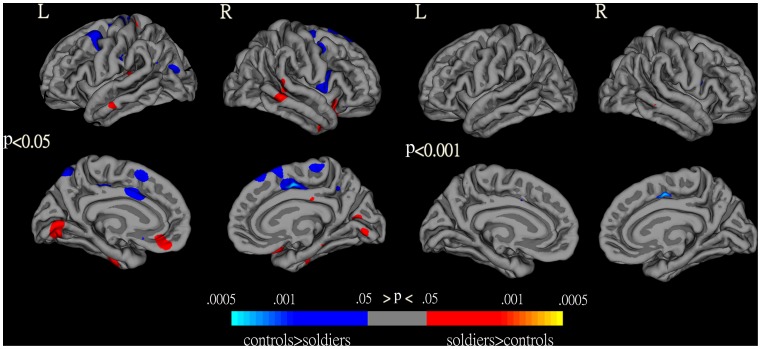
Changed cortical thickness in HA immigrants compared with SL controls as revealed by surface-based analysis.Maps are presented on the pial cortical surface.